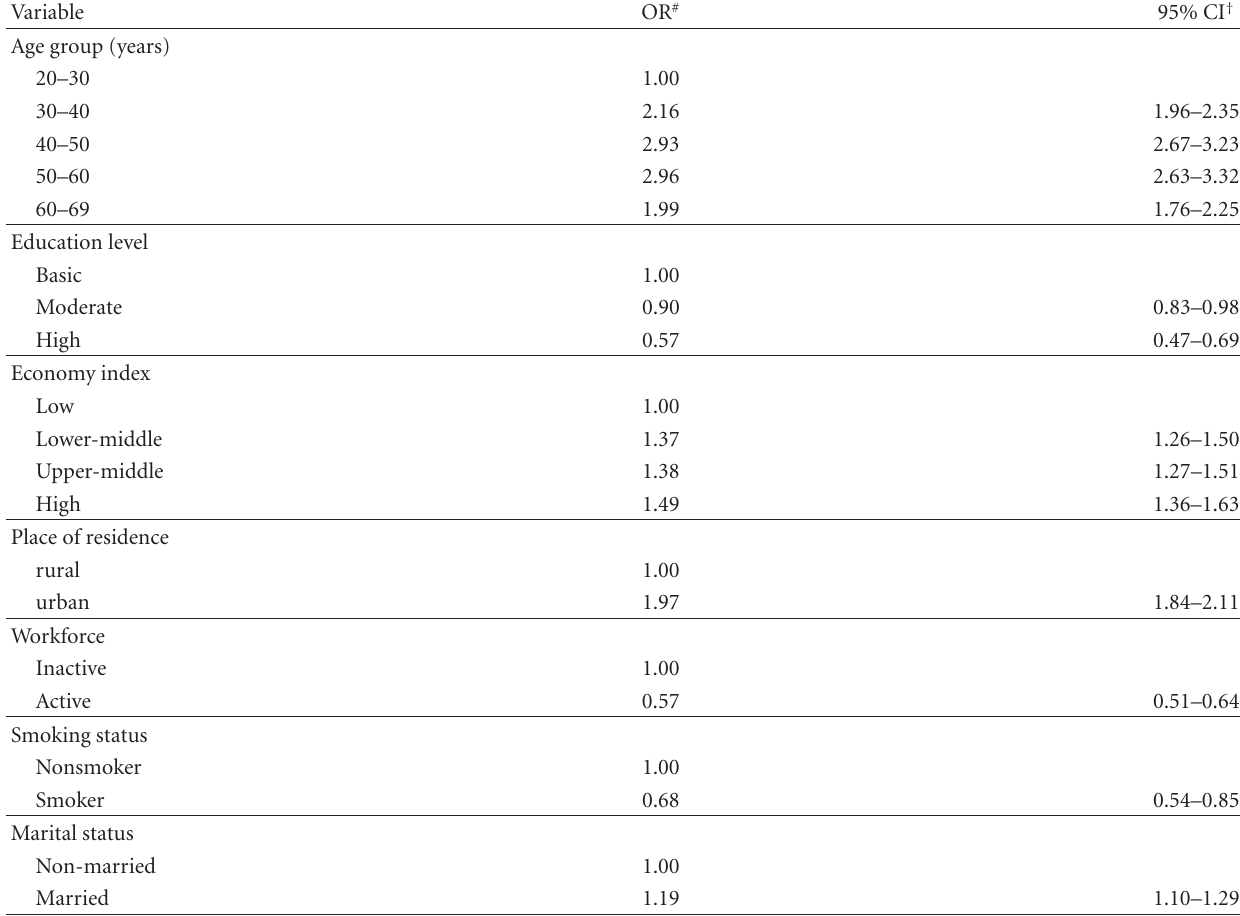
Table 2: Adjusted ∗ odds ratios for the likelihood of being overweight and obese §‡ , by sociodemographic and smoking among random sample of 14176 Iranian women in the proportional odds model,